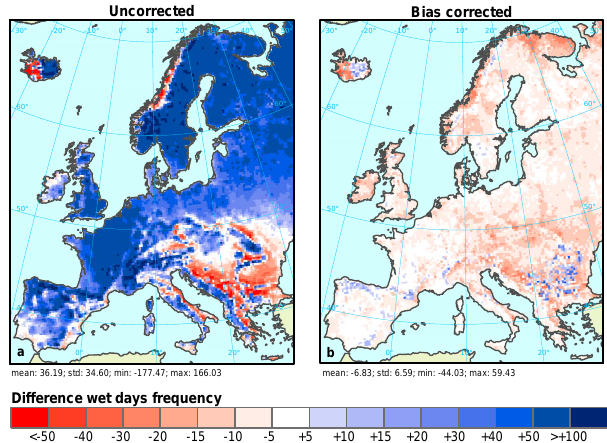
Fig. 3. Difference of average annual wet day frequency (precipi- tation ≥ 1mmd − 1 ) between (a) uncorrected precipitation and (b) bias corrected precipitation with respect to the E-OBS data set for the control period